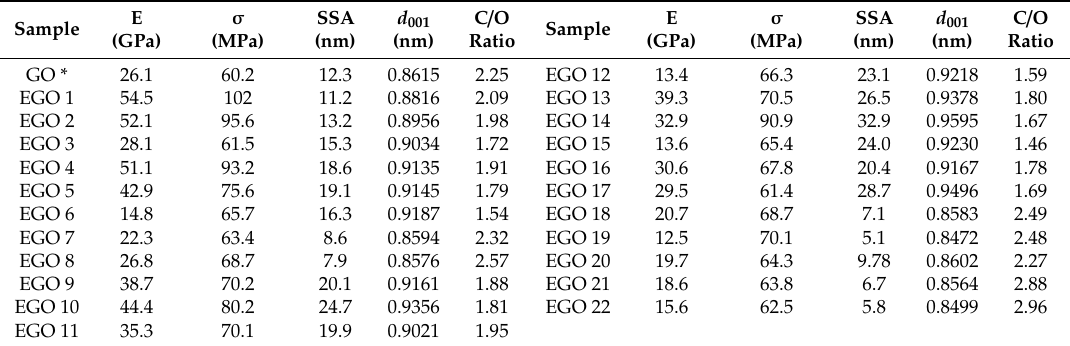
Table 3. Mechanical properties of the EGOs obtained from tensile experiments and their relation to the specific surface area (SSA), interlayer distance d , and C/O ratio.